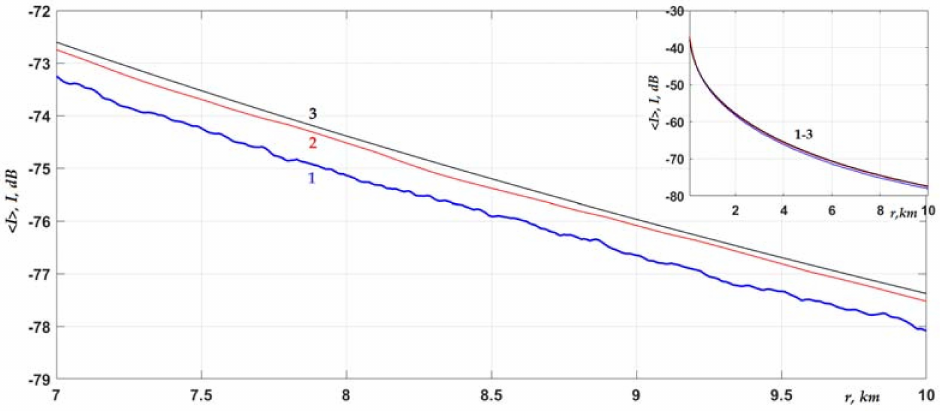
Figure 9. Average decay laws for the average intensity in a random waveguide with bathymetry fluctuations, f = 500 Hz. (cid:104) c 1 (cid:105) = 1500 m/s, δ c 1 = 0. z = z 0 = 36 m. Curves: 1 is OW solution, L h = 100 m; 2 is OW solution, L h = 1 km; 3 is intensity I in the unperturbed waveguide ( δ h =